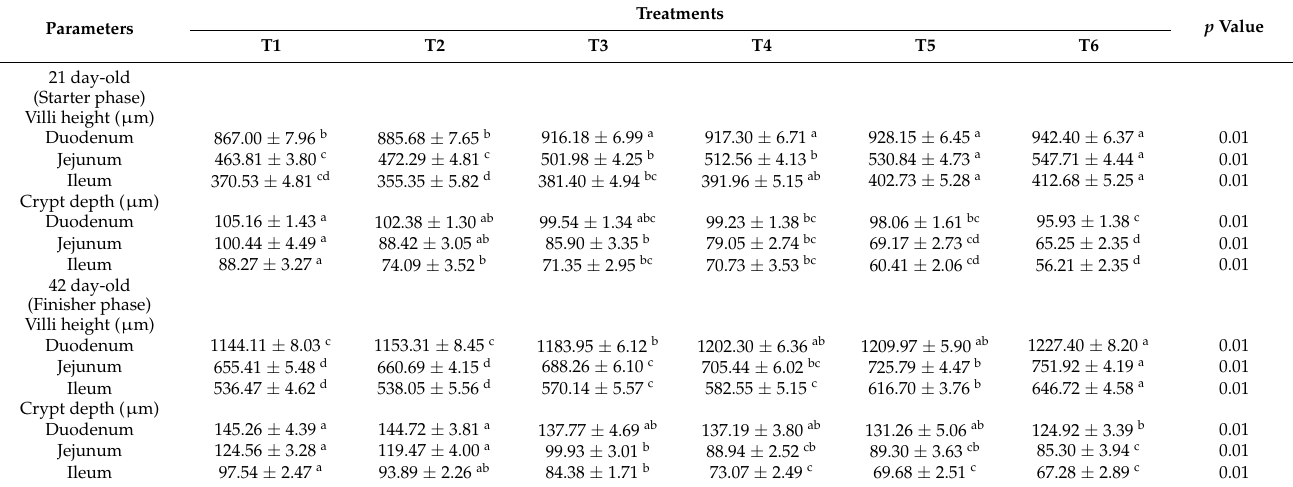
Table 4. Effect of Y. schidigera supplementation on the small intestinal villus height and crypt depth of broilers on day 21 and